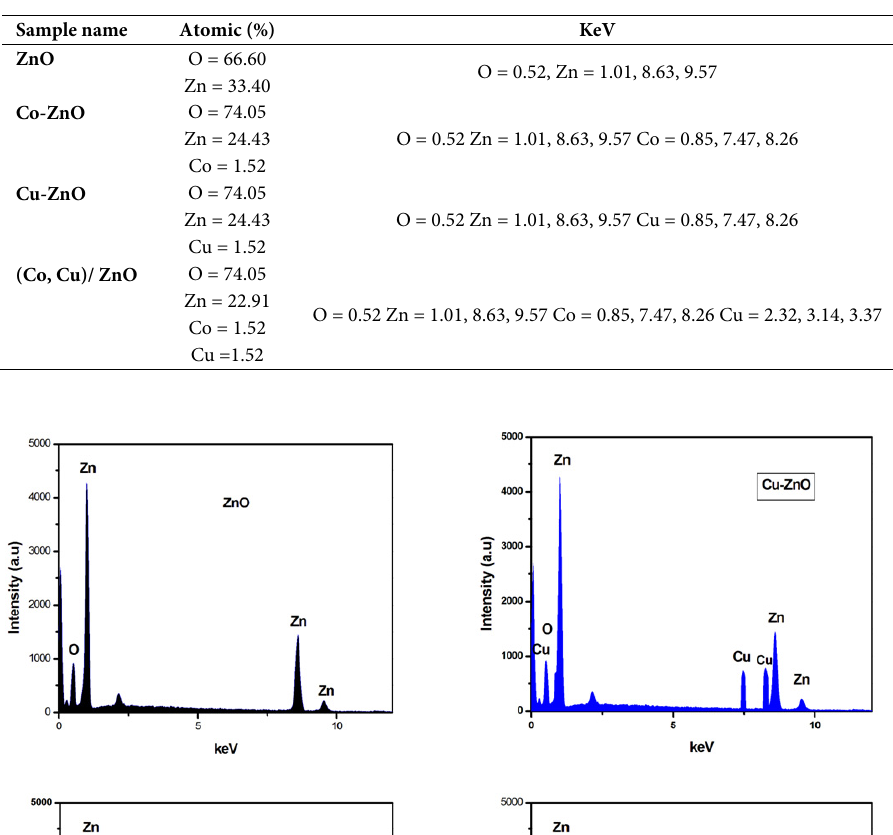
Table. 1 EDX elemental analysis of Co-Zno, Cu-ZnO and (Co, Cu)/ ZnO